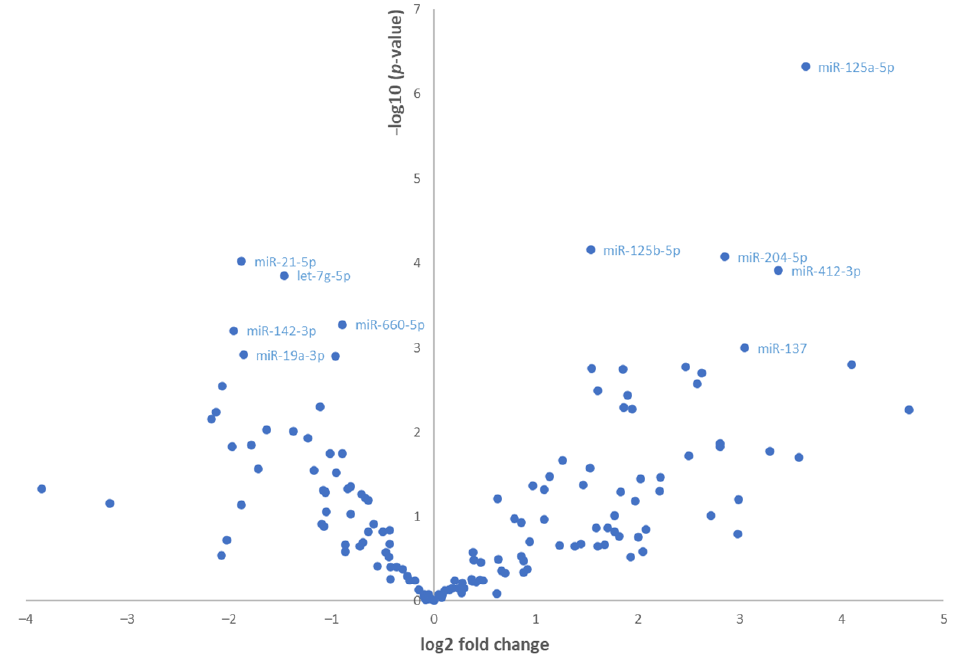
Figure 2. Volcano plot demonstrating the relationship between the p -values and the fold change of miRNA expression (dCq) between PDR and the control group. The labels indicate the ten most differentially expressed miRNAs.